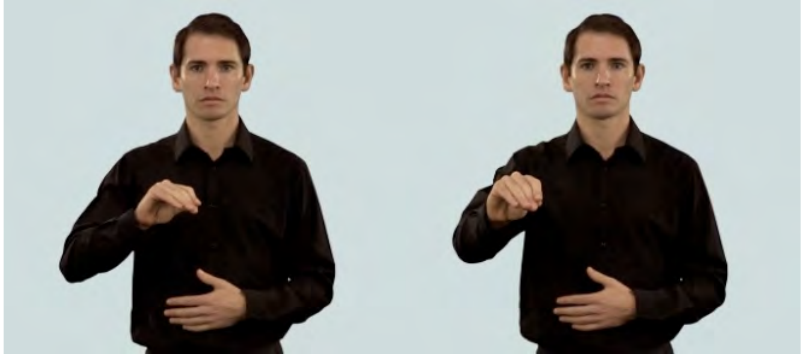
Figure 5. Indicating verb move in